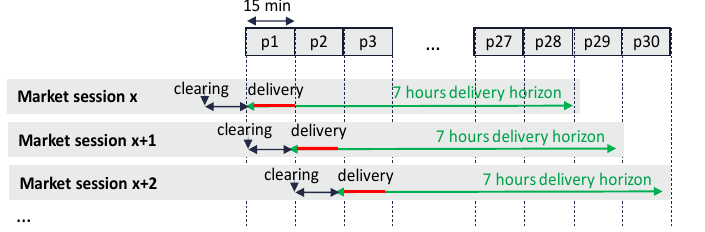
Figure 2. Market Clearing.